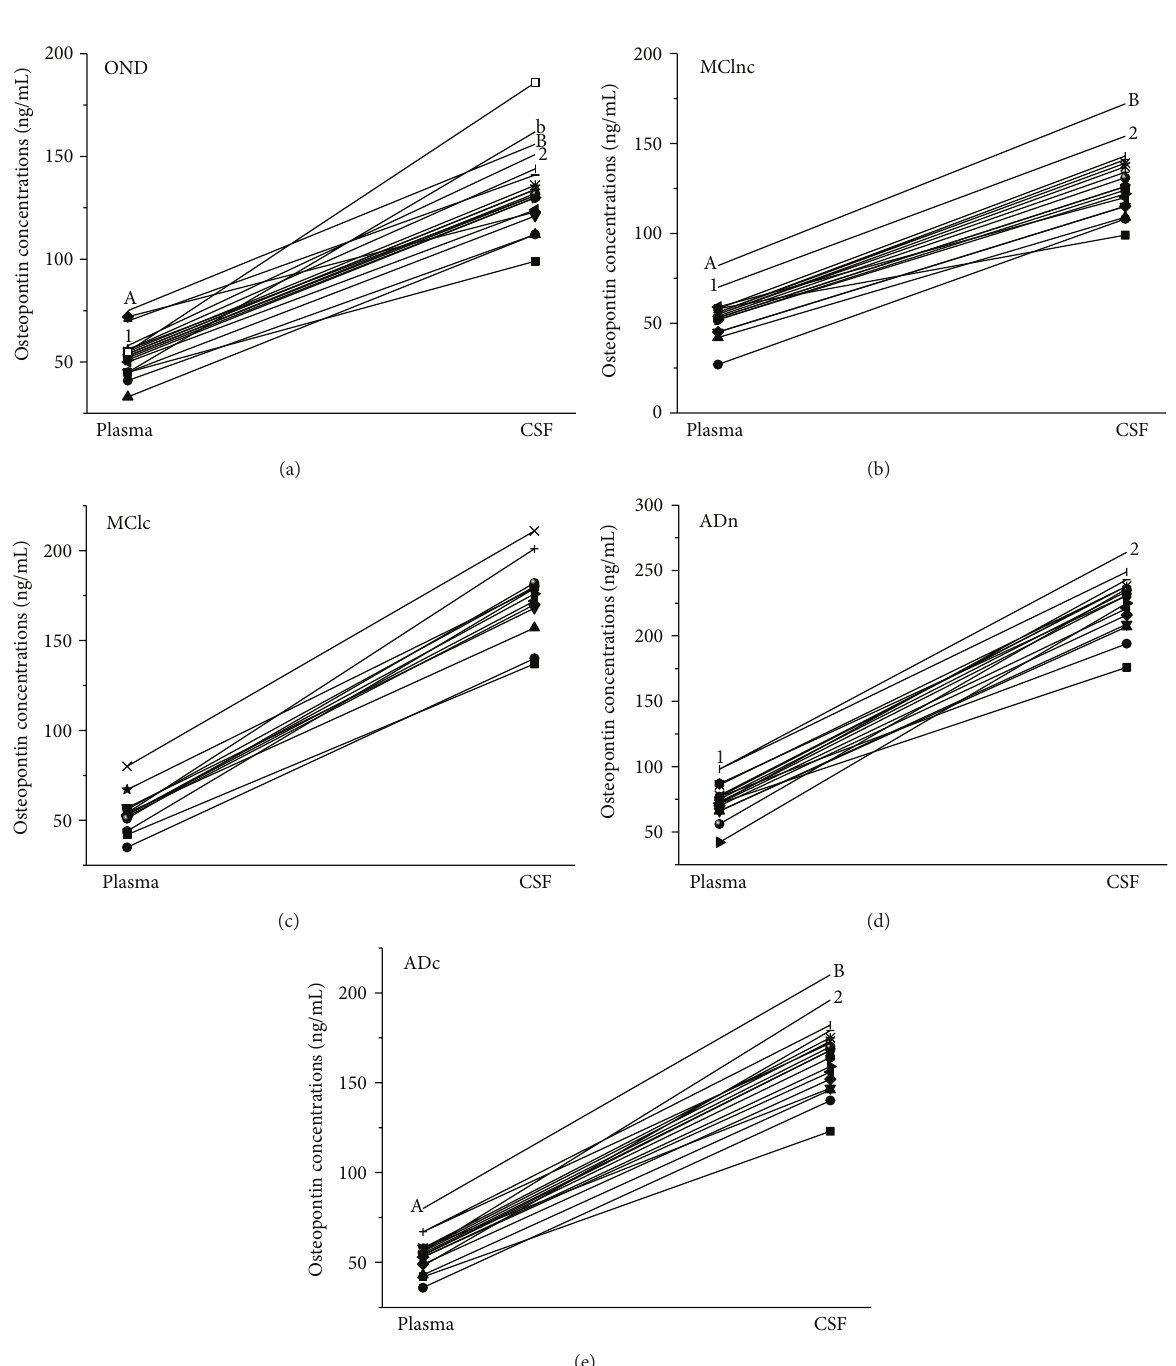
Figure 3: The concentrations of osteopontin in the cerebrospinal fluid (CSF) were significantly higher compared to peripheral blood in patients with other noninflammatory neurologic diseases (OND, 𝑛 = 20 ), clinically stable mild cognitive impairment patients (MCInc, 𝑛 = 18 ), mild cognitive impairment converters (MCIc, 𝑛 = 13 ), newly diagnosed AD (ADn, 𝑛 = 17 ), and chronical AD patients (ADc, 𝑛 = 18